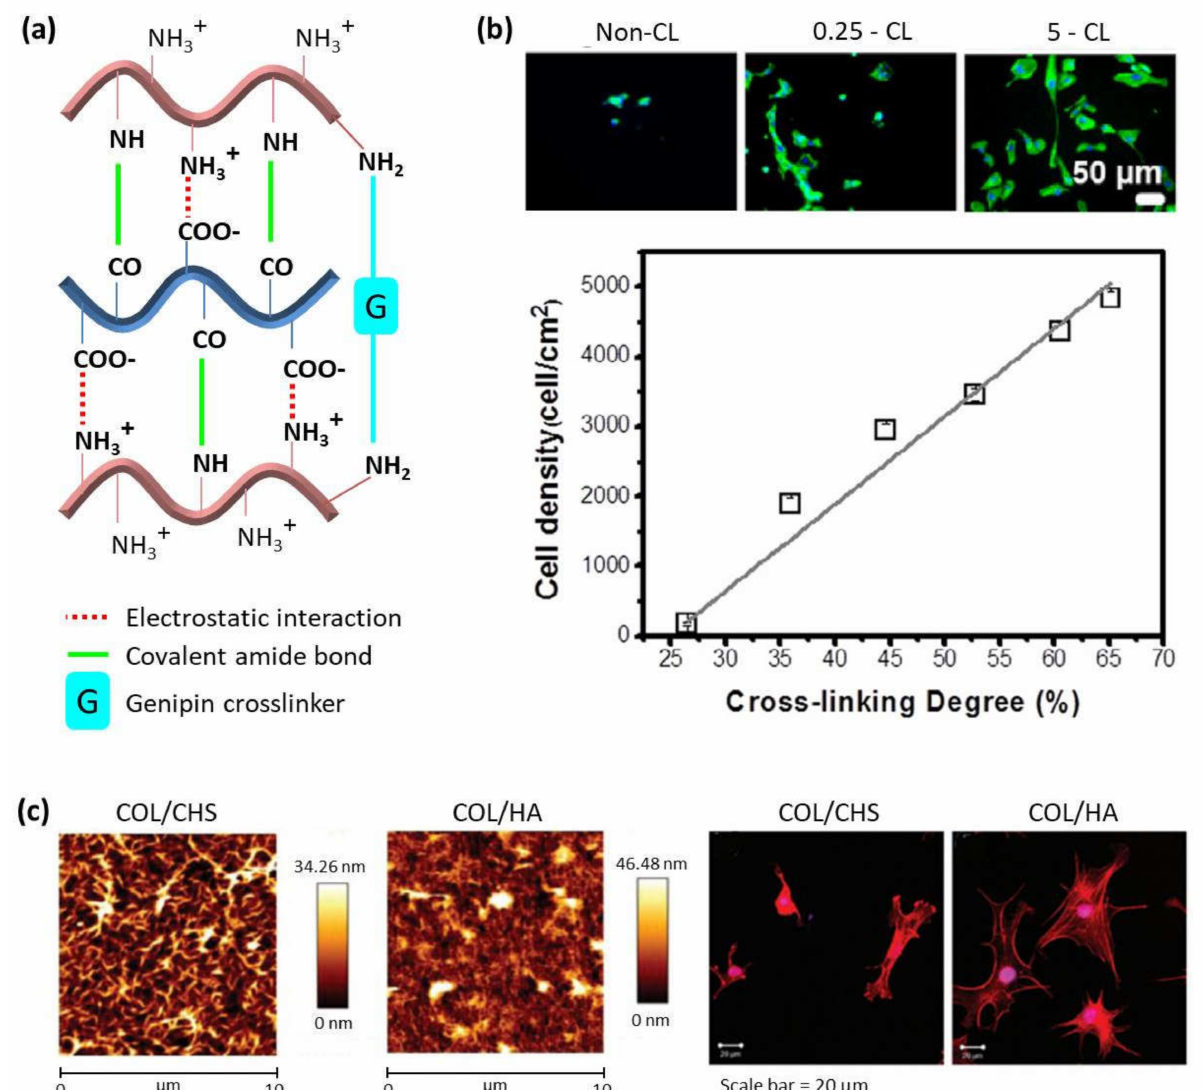
Figure 4. ( a ) Schematic representation of different cross-linking mechanisms in LbL films made of chitosan and alginate or hyaluronic acid; ( b ) DAPI-phalloidin fluorescence assay at 1 day of HUVECs cell culture in multilayers with different cross-linking degrees (top) and cell density as a function of cross-linking degree (bottom). (Adapted and reprinted with permission from [75]; Copyright 2017 Acta Materialia Inc. Published by Elsevier Ltd. All rights reserved.); ( c ) AFM images of (CHI/CHS) 10 and (CHI/HA) 10 films (top) and phalloidin-stained bovine chondrocytes cultured on (CHI/CHS) 10 and (CHI/HA) 10 films (bottom) (Adapted and reprinted with permission from Ref [44]. Copyright 2011 American Chemical